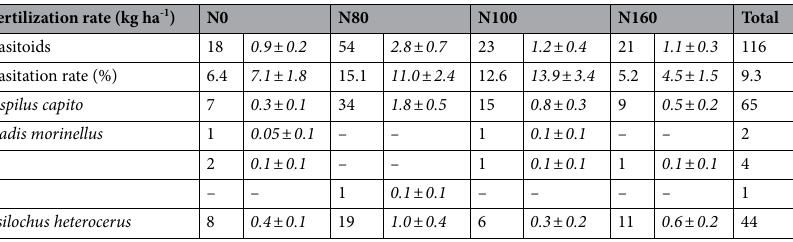
Table 4. Total and average ± SE number of Brassicogethes aeneus larvae parasitism rates and the total numbers of parasitoid offspring species collected from oilseed rape plants under different nitrogen (N) treatments. The average values and standard errors are in